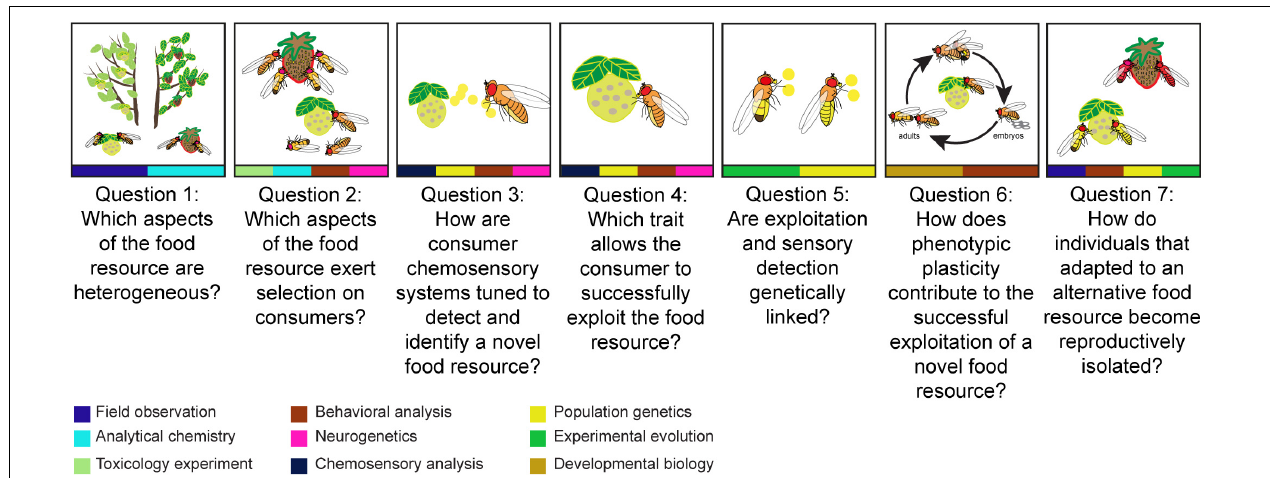
FIGURE 1 | An overview of seven key questions that can be used to explore the processes leading up to resource-mediated ecological speciation, with methods at the bottom that can be used to study each question. To dissect resource-mediated ecological speciation, we first need to understand the different forms of food resource heterogeneity which could be variation in spatial location, temporal availability, and chemical composition of different food resources like the yellow and red fruits (Question 1). Then, it is important to identify which aspects of the food resources exert selection on consumers (Question 2). It could be because of the toxicity of the food resources. For example, flies which feed on yellow fruit but do not tolerate the associated toxins will die. To understand how consumers interact with food resources, it is necessary to explore how consumers detect (Question 3), exploit (Question 4), and adapt to heterogeneous resources (Question 5). Consumers can detect food resources by food odors (represented by yellow dots), exploit food resources by tolerating defensive compounds (represented by yellow proboscis) and adapt to food resources by the coupling of detection and digestion (represented by yellow odor dots and abdomen). Apart from genetic variation, phenotypic plasticity also modulates consumers’ exploitation of a resource (Question 6). Phenotypic plasticity determines whether successful exploitation can be learned and modified during an individual’s lifetime (represented by life cycles of flies). Finally, we come to the mechanisms preventing gene flow between individuals that specialized on alternative resources and those that did not (Question 7). When mating takes place at a specific food resource, while alternative resources are available, assortative mating can emerge as a by-product of divergence in foraging behavior. For example, the yellow flies are isolated from red flies. The approaches presented by the color at the bottom of each panel from left to right are: field observation (navy blue), analytical chemistry (light blue), toxicology experiment (light green), behavioral analysis (dark red), neurogenetics (pink), chemosensory analysis (dark blue), population genetics (yellow), experimental evolution (dark green), and developmental biology